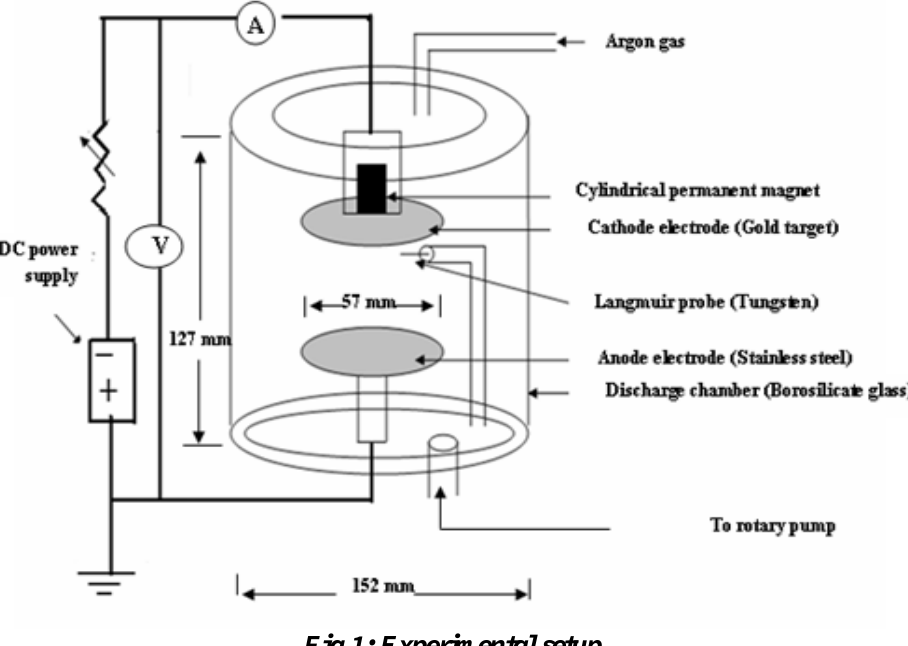
Fig.1: Experimental